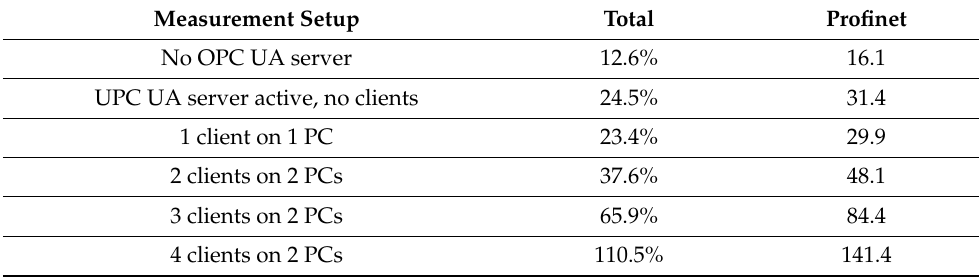
Table 5. Results for the 2.4 GHz wireless connection without the SCALANCE switches with a 128 ms update